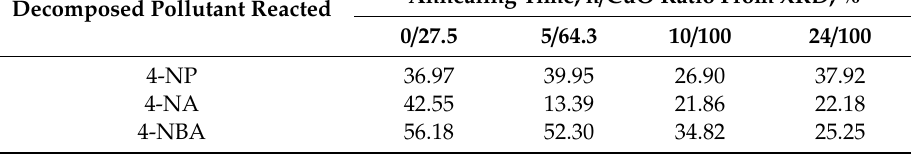
Table 2. Change in the E a (kJ / mol) value as a function of annealing time and CuO phase ratio as obtained from XRD data.